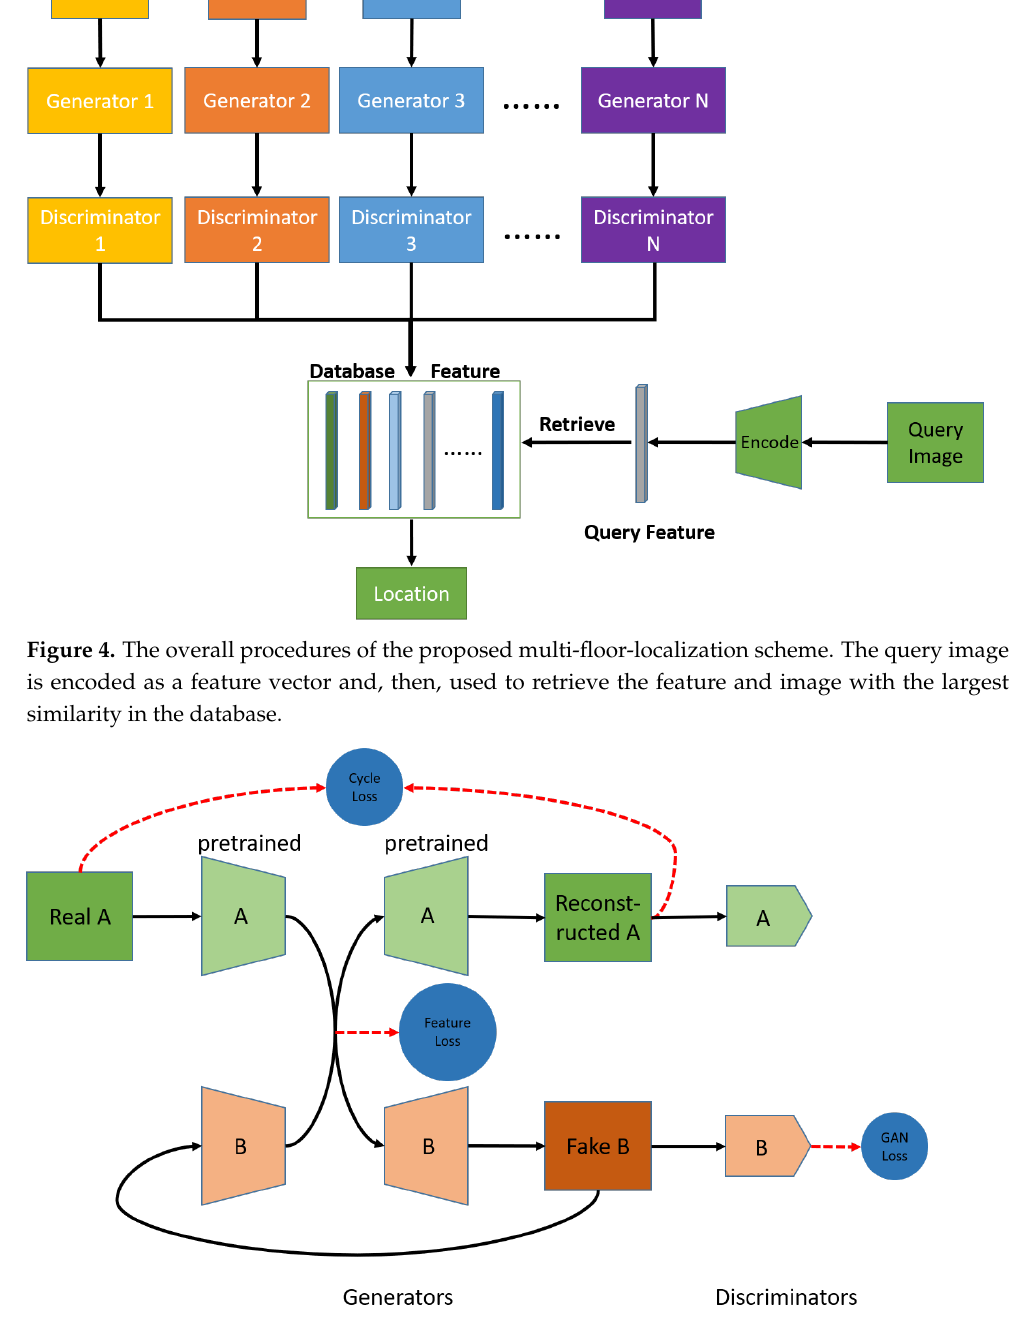
Figure 5. The proposed GAN-based localization architecture, which consists of generators and discriminators. The generators are divided into domain-specific pairs of encoders and decoders for each domain. The architecture of translation is A → B, where A and B are randomly selected. The pass B → A is performed in the same